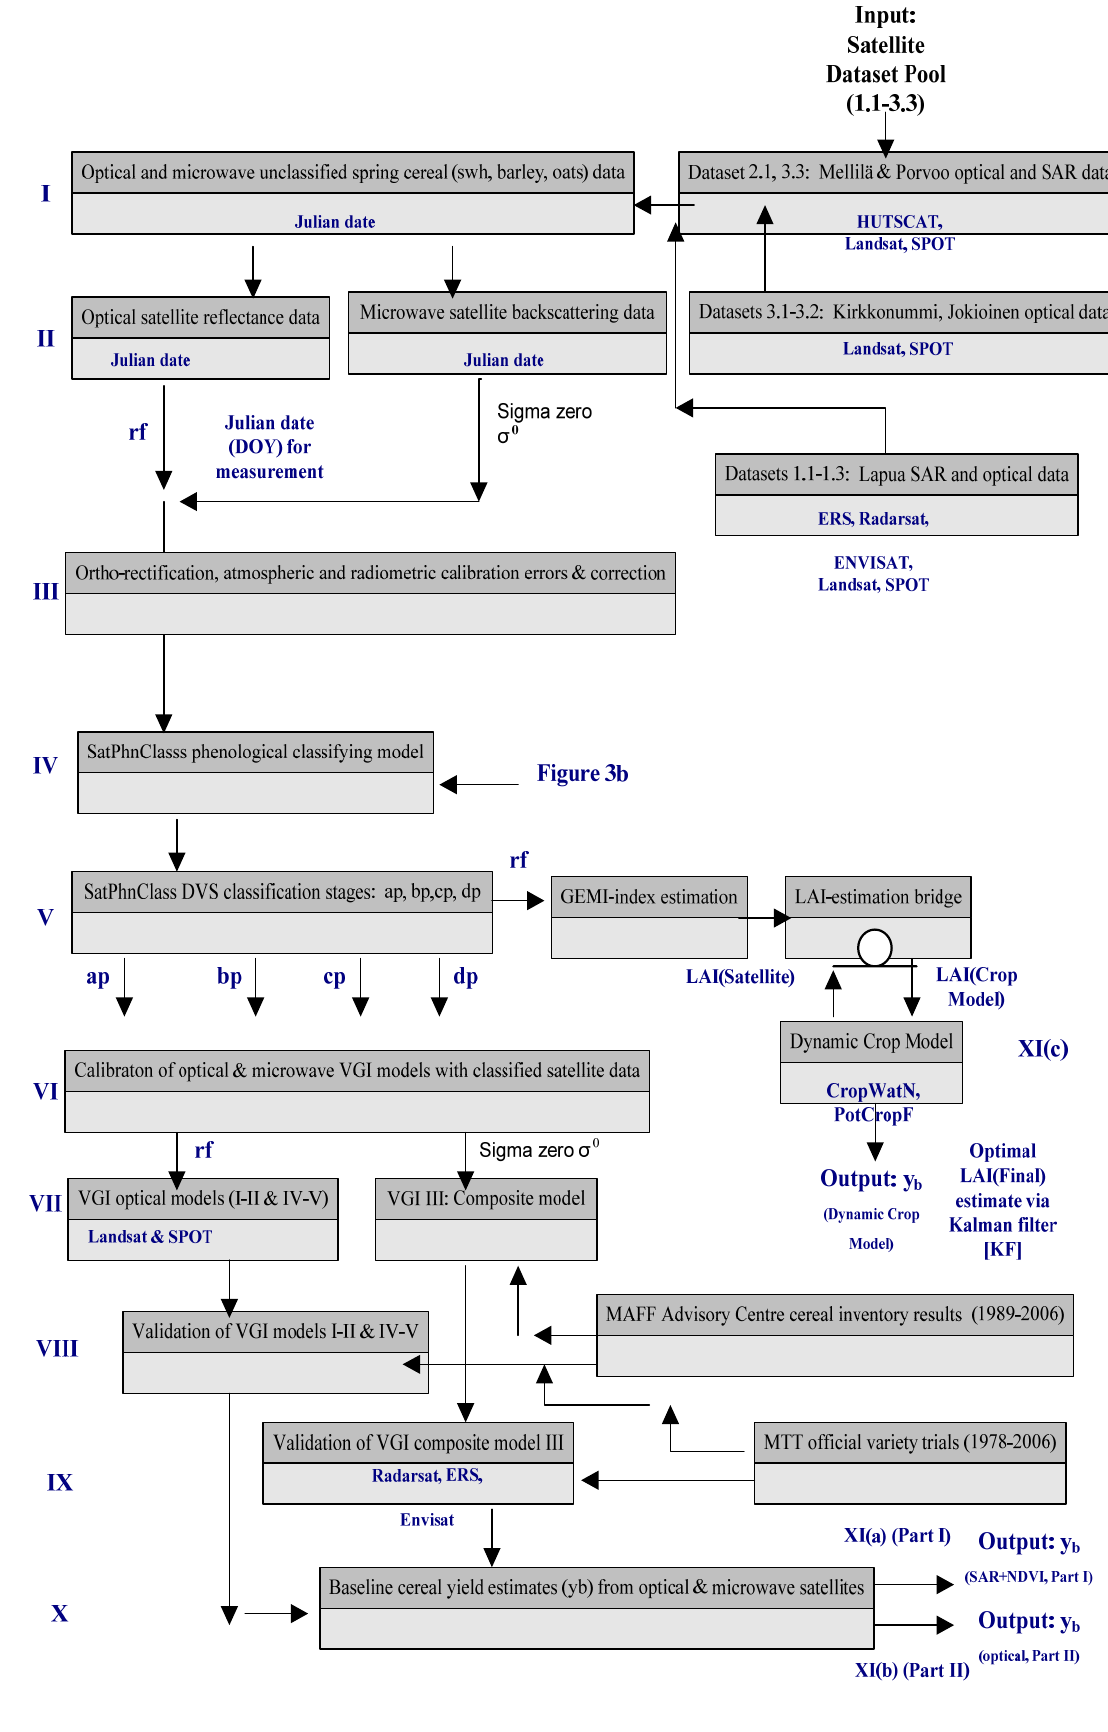
Figure 1. System Analysis and design diagram by satellite systems and VGI models